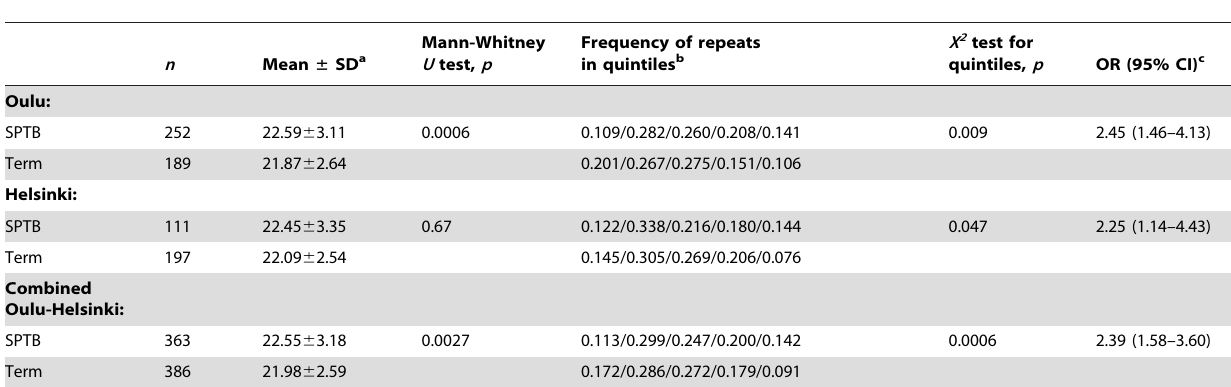
Table 5. AR CAG repeat distributions in individuals born spontaneously preterm and in those born at term.